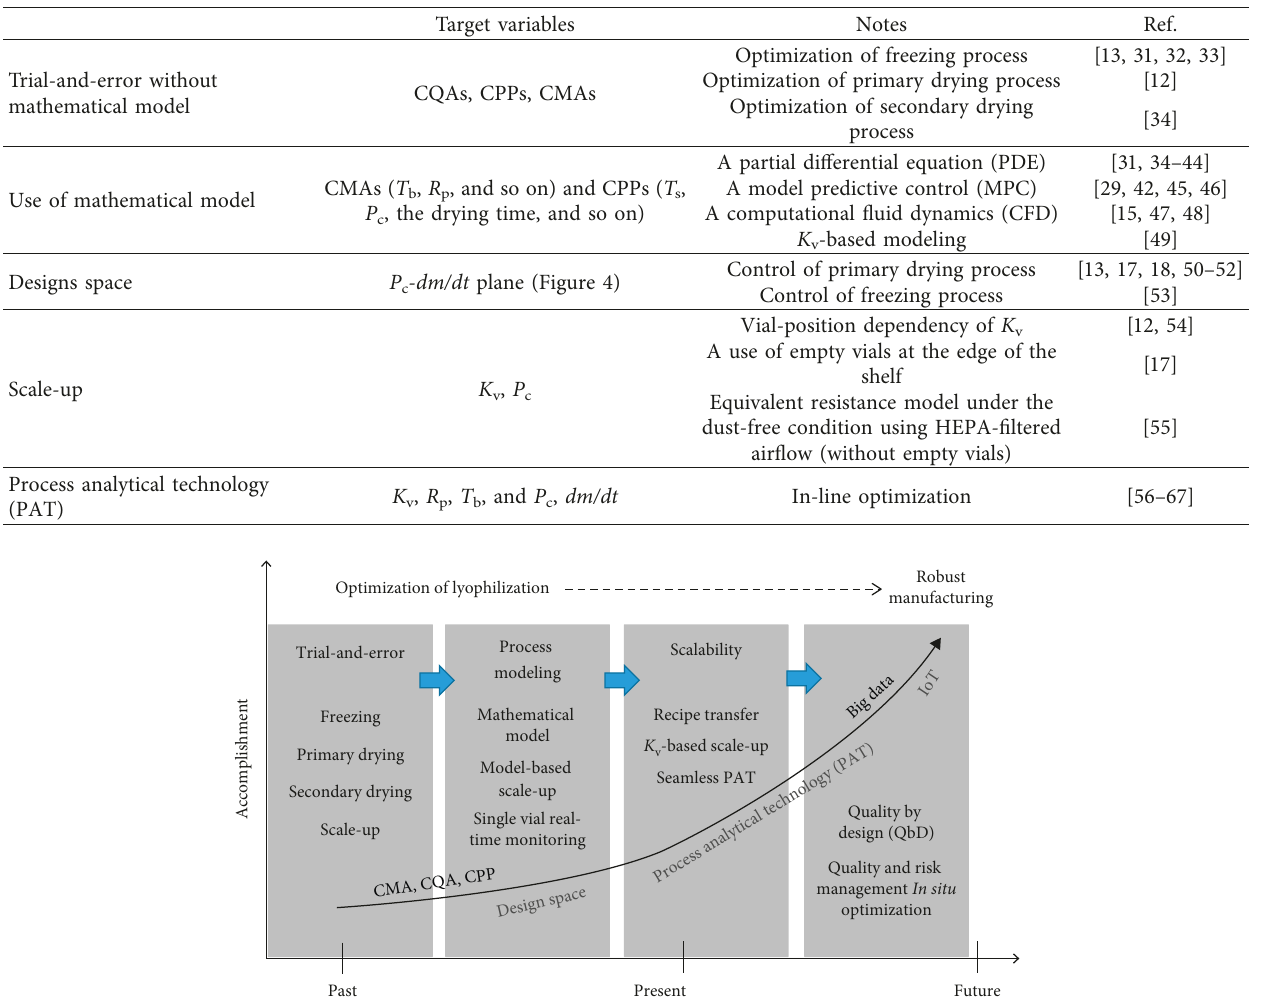
Table 2: Summary of the optimization of